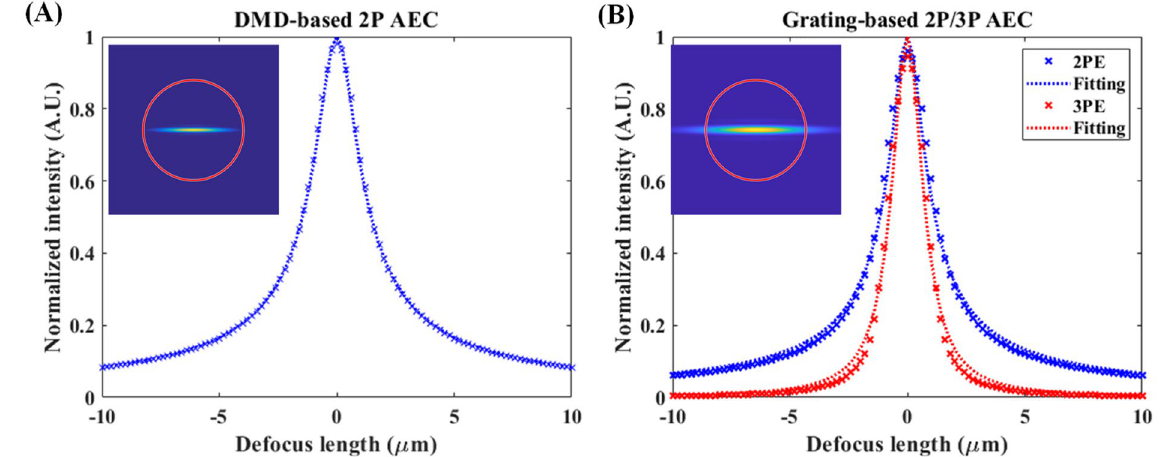
Figure 1. Simulated AEC of UPlanSApo 60XW objective lens in: ( A ) DMD-based 2P TFMPEM 32 and ( B ) grating-based 2P and 3P TFMPEM 37 . For both figures, the inserts show the intensity distribution of the dispersed beam at the back focal plane of the objective lens. In addition, the red circles indicate the effective coverage of the back aperture, which is approximately 5.4 mm in diameter.